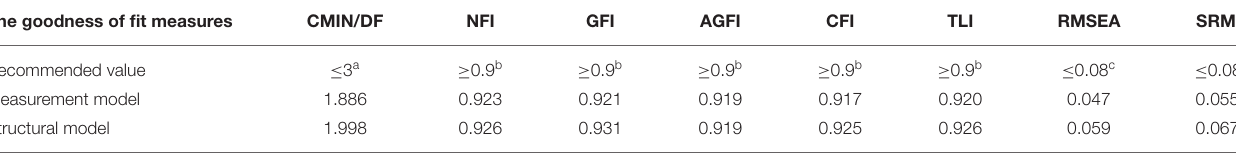
TABLE 1 | Evaluating the Structural and measurement models. The goodness of fit